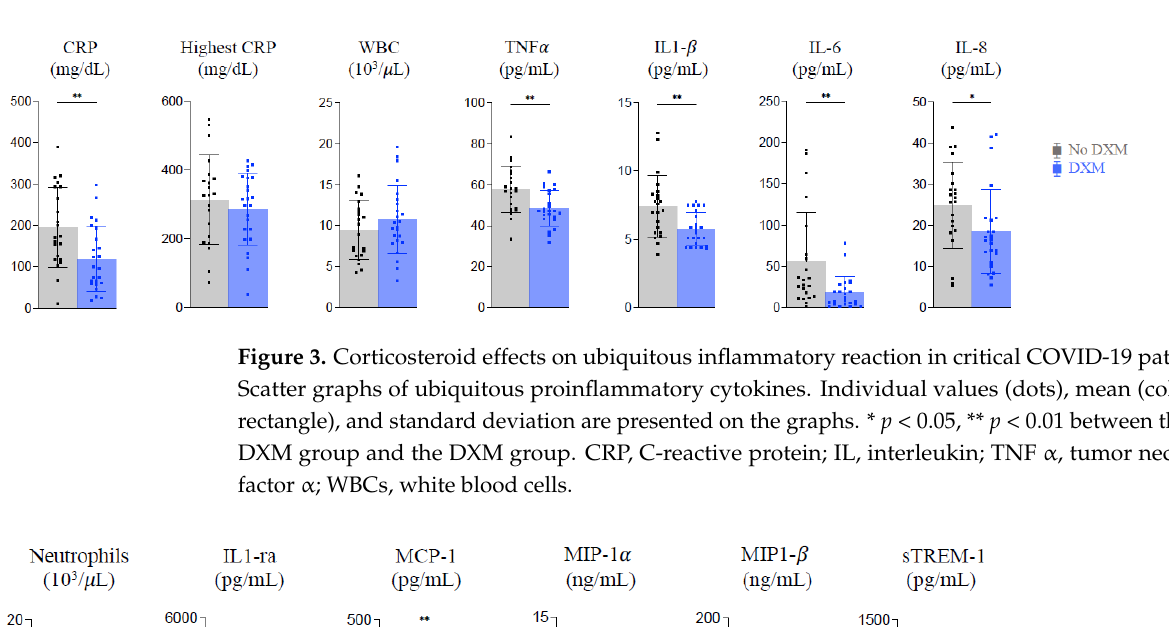
Figure 3. Corticosteroid e ff ects on ubiquitous in fl ammatory reaction in critical COVID-19 patients. Sca tt er graphs of ubiquitous proin fl ammatory cytokines. Individual values (dots), mean (colored rectangle), and standard deviation are presented on the graphs. * p < 0.05, ** p < 0.01 between the no DXM group and the DXM group. CRP, C-reactive protein; IL, interleukin; TNF α , tumor necrosis factor α ; WBCs, white blood cells.